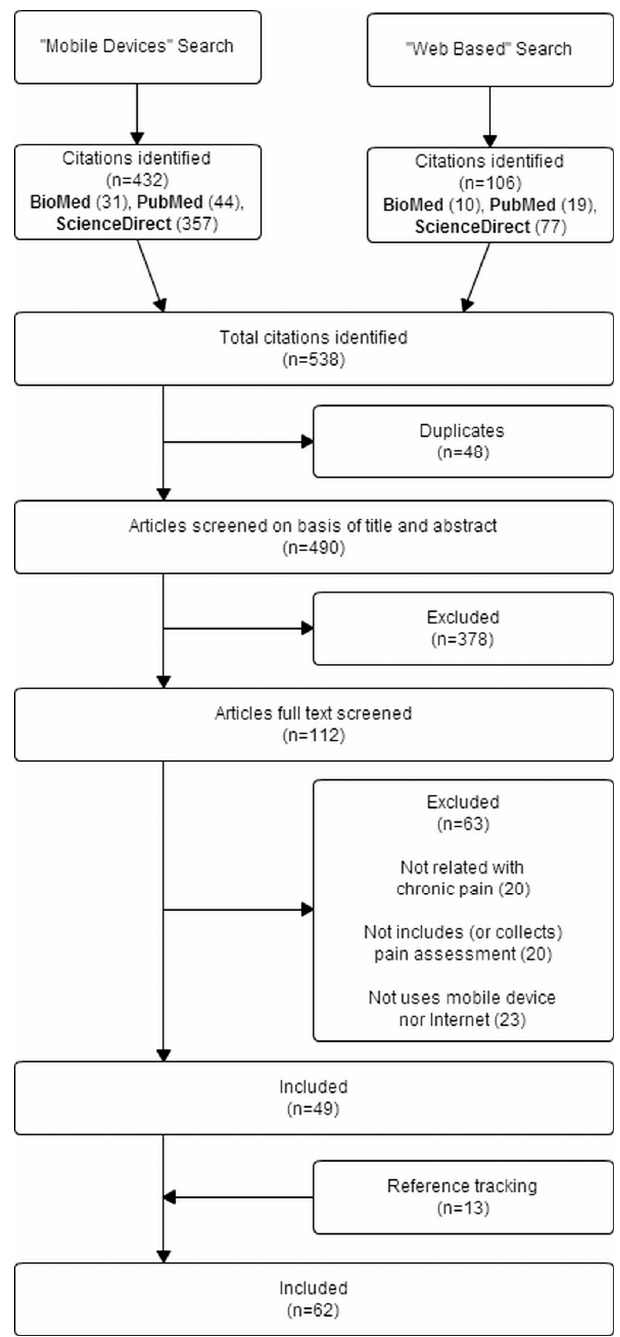
Figure 3. Selected studies.